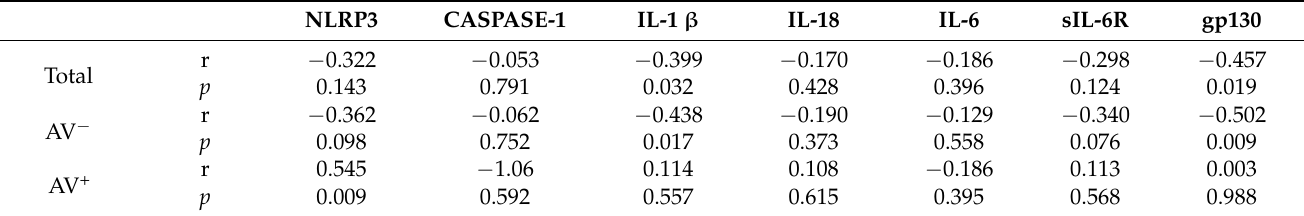
Table 3. Bivariate correlations between levels of total, AV − , and AV + MVs and the gene expression of inflammasome-related markers in thrombi.